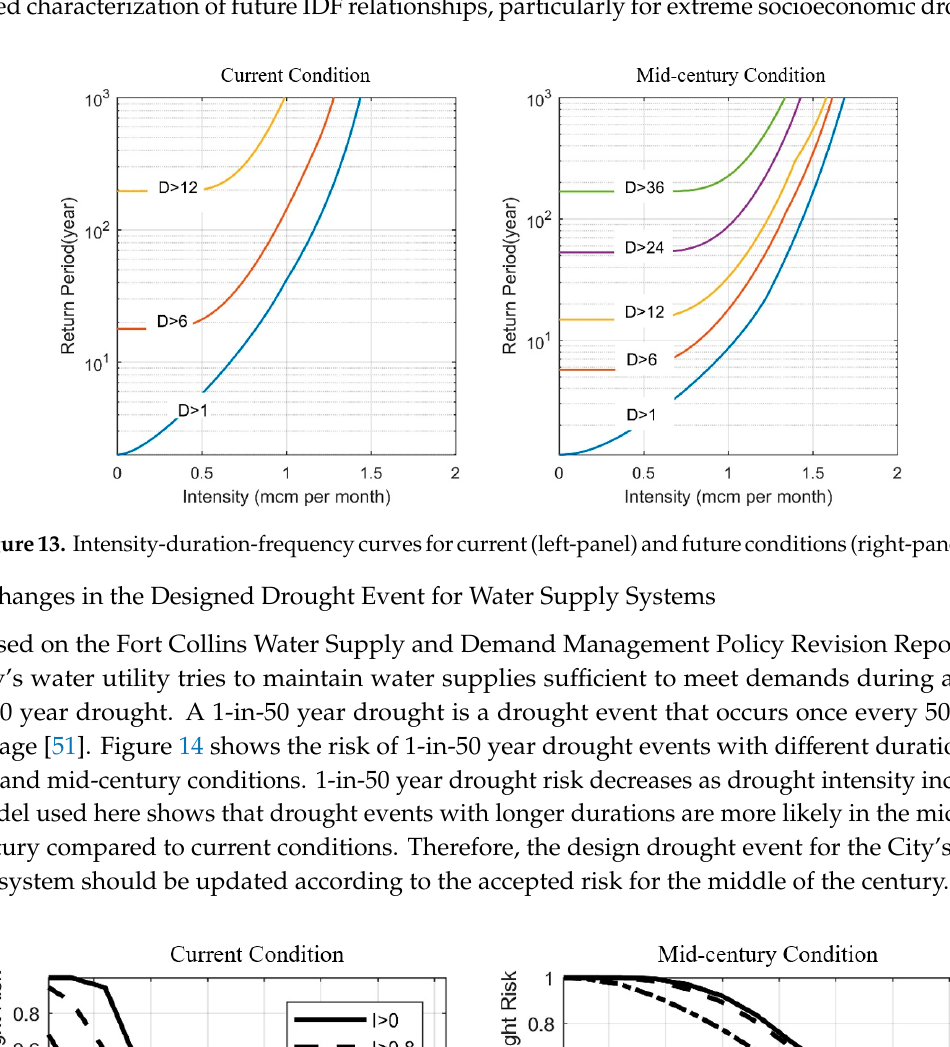
Figure 12. Amplification factor curves for frequency of drought events (intensity is in mcm/month).